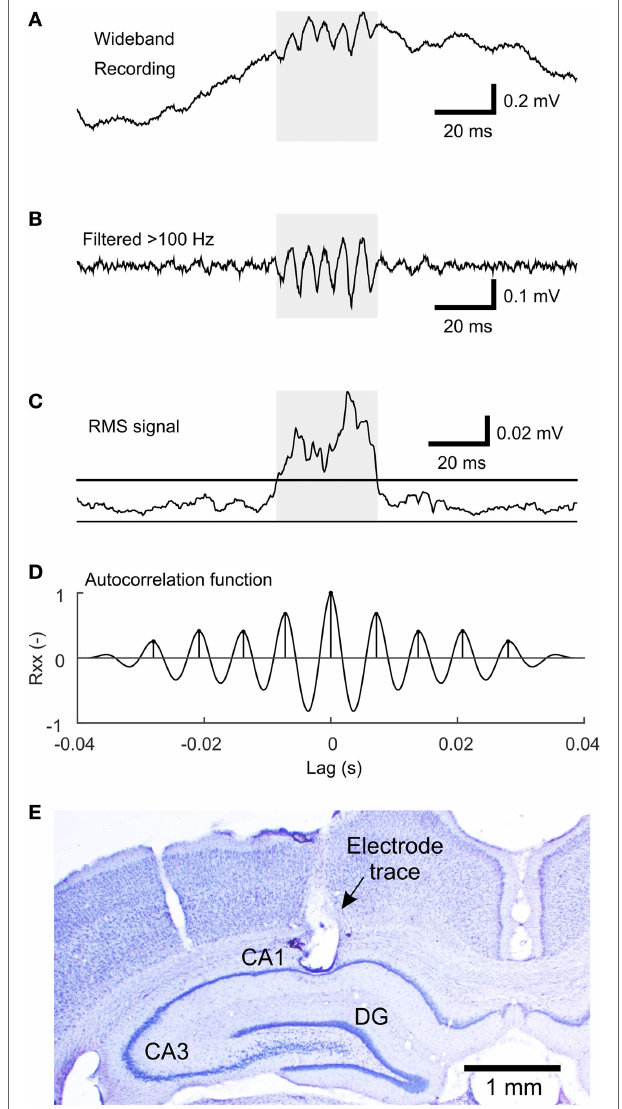
FigUre 1 | The algorithm of sharp-wave ripple (SWR) detection. (a) An example of the wideband signal containing an SWR event. (B) High-pass filtered ( > 100 Hz) signal reveals the ripple oscillation. (c) Root mean square (RMS) signal computed from the high-pass filtered signal. The line indicates the detection threshold. The shaded area marks the putative detection. (D) The autocorrelation function of the shaded segment of the high-pass filtered signal with detected peaks, which fulfills the criteria for SWR detection. (e) An example of a Nissl-stained brain slice with electrode tip located in stratum pyramidale of the CA1 hippocampal